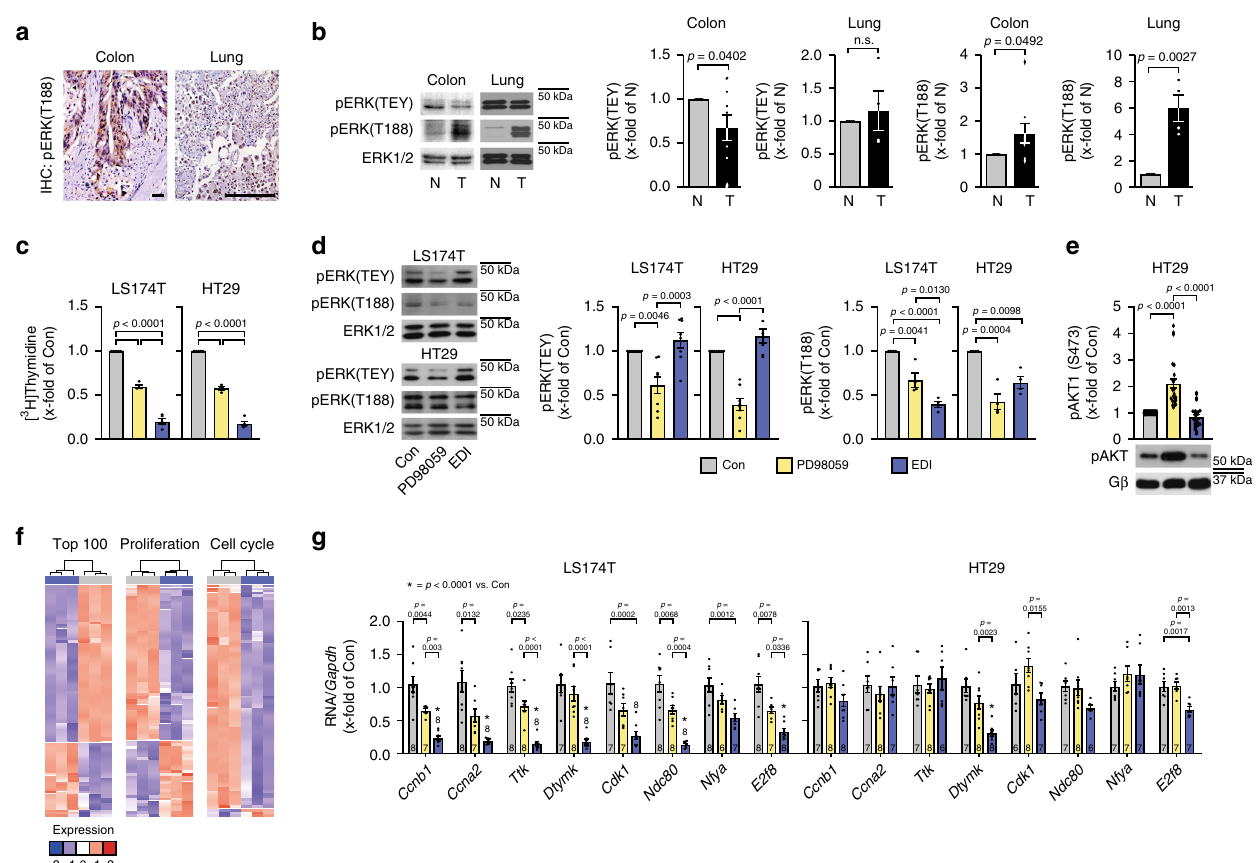
Fig. 5 EDI reduces tumor cell proliferation. a , b Analysis of human colon adenocarcinoma and lung cancer. a Immunohistochemistry (IHC) of pERK(T188) (left: colon, scale bar 50 μ m, n = 9; right: lung, 200 µ m, n = 5). b Representative western blots and quanti fi cations of pERK[TEY] and pERK[T188]) (colon, n = 9 patients; lung, n = 4 patients; normal (N) and tumor (T) tissue). c – g LS174T and HT29 colon cancer cells transduced with LacZ (Con) or EDI and pretreated with PD98059 (30 µ M, 48 h ( c ) or 24 h ( d , e )). c [ 3 H]Thymidine incorporation (Con, PD98059, n = 4; EDI n = 5). d Respresentative western blots and quanti fi cations of pERK(TEY) and pERK(T188) (LS174T: pERK[TEY], n = 8; pERK[T188], n = 4; HT29: pERK[TEY], n = 7; pERK[T188], n = 4). e Representative western blots and western blot analyses of pAKT1(S473) in HT29 cells treated as described above ( n = 28). f Microarray gene expression analysis of LS174T transduced with Con or EDI ( n = 3 per condition). Heatmaps of top 100 genes with highest variance across samples and of transcriptional changes of genes related to proliferation and cell cycle. g mRNA expression of cyclin B1 ( Ccnb1 ), cyclin A2 ( Ccna2 ), TTK Protein Kinase ( Ttk ), alpha ( Nfya ), and E2F transcription factor 8 ( E2f8 ) normalized to glycerinaldehyde-3-phosphate dehydrogenase ( Gapdh ). Error bars are mean ± s.e.m.; n numbers represent biologically independent experiments; n numbers of g are displayed in the graph; ordinary one-way ANOVA ( c – e , g ) and Bonferroni as post hoc test was applied except for b where an unpaired and two-sided Student ’ s t -test was applied. Source data are provided as a Source Data fi